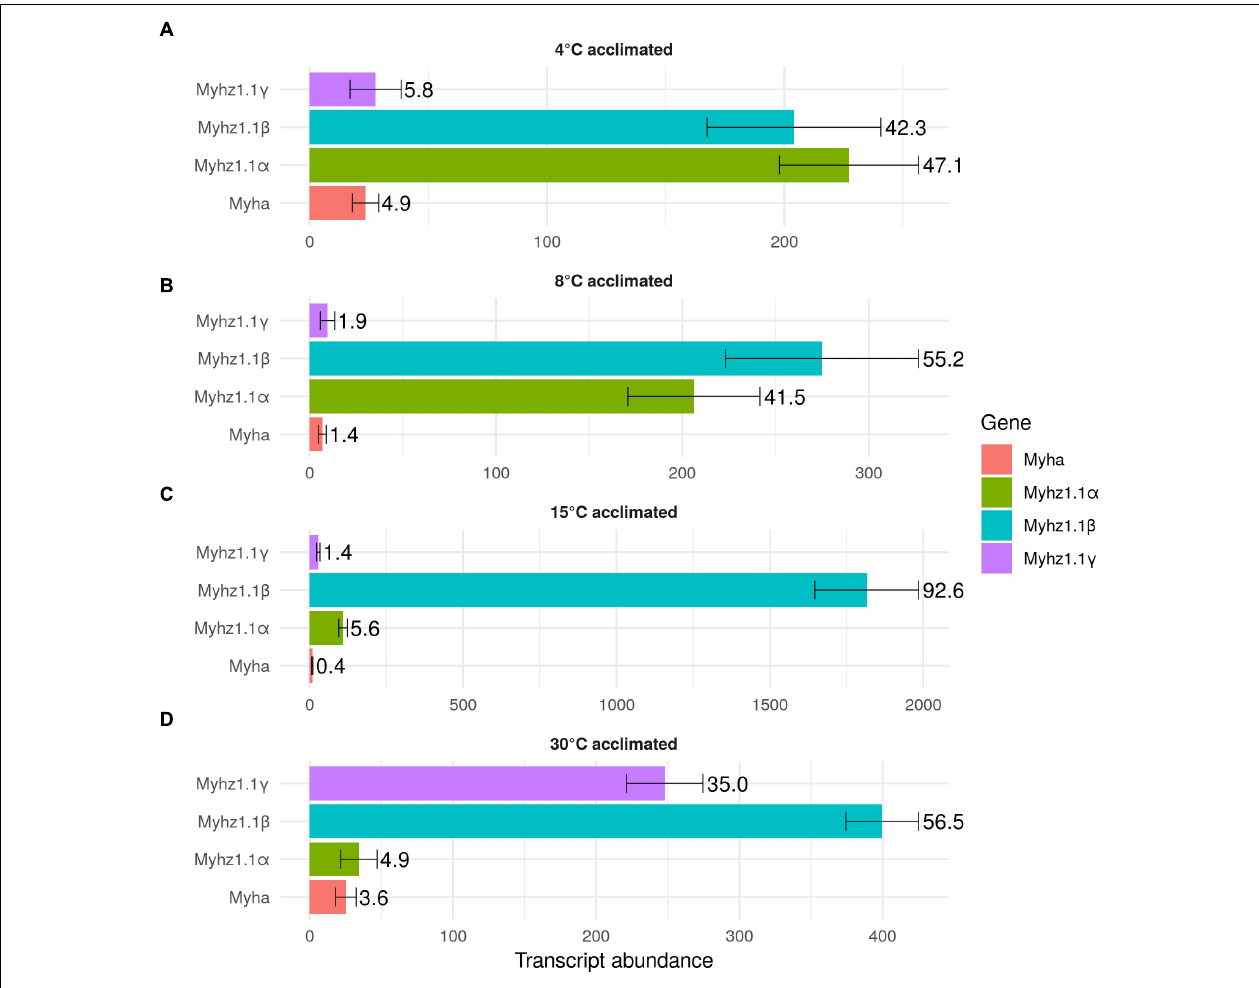
FIGURE 3 | Transcript abundance of the main myosin heavy chain transcripts in goldfish fast skeletal muscle. Values represent Mean ± SD transcript copy number normalized to the reference gene. The transcripts of myosin heavy chain orthologs myhz1.1 α (green), myhz1.1 β (blue), myhz1.1 γ (purple), and myha (red) in response to long-term acclimation to 4, 8, 15, and 30 ◦ C are illustrated. To ease interpretation, the percentage of each transcript is shown to the right of each bar. (A) 4 ◦ C acclimated, (B) 8 ◦ C acclimated, (C) 15 ◦ C acclimated and (D) 30 ◦ C